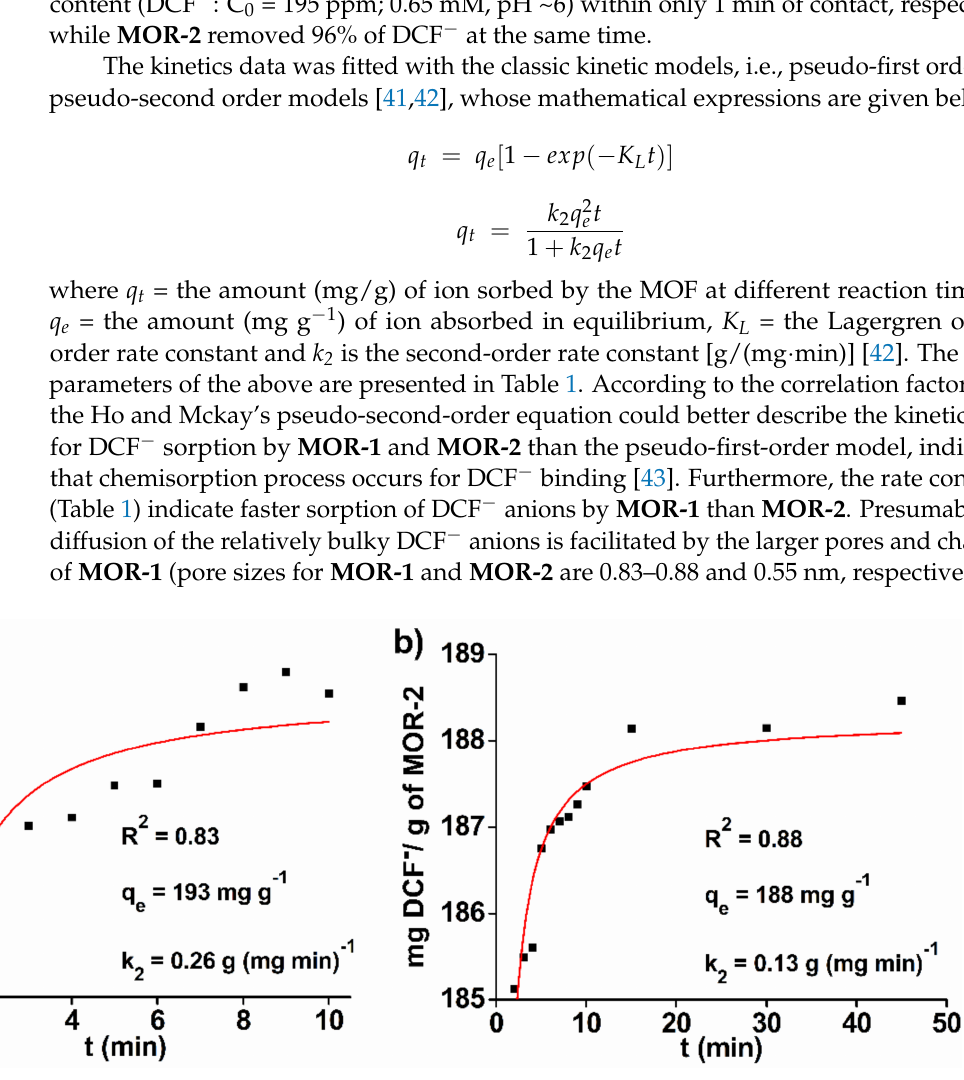
Figure 2. Fitting of the kinetics data (solid line) with the Ho–Mckay’s second-order equation for the sorption of DCF − by MOR-1 ( a ) and MOR-2 ( b ). Table 1. Sorption kinetic parameters of MOR-1 and MOR-2 for DCF −